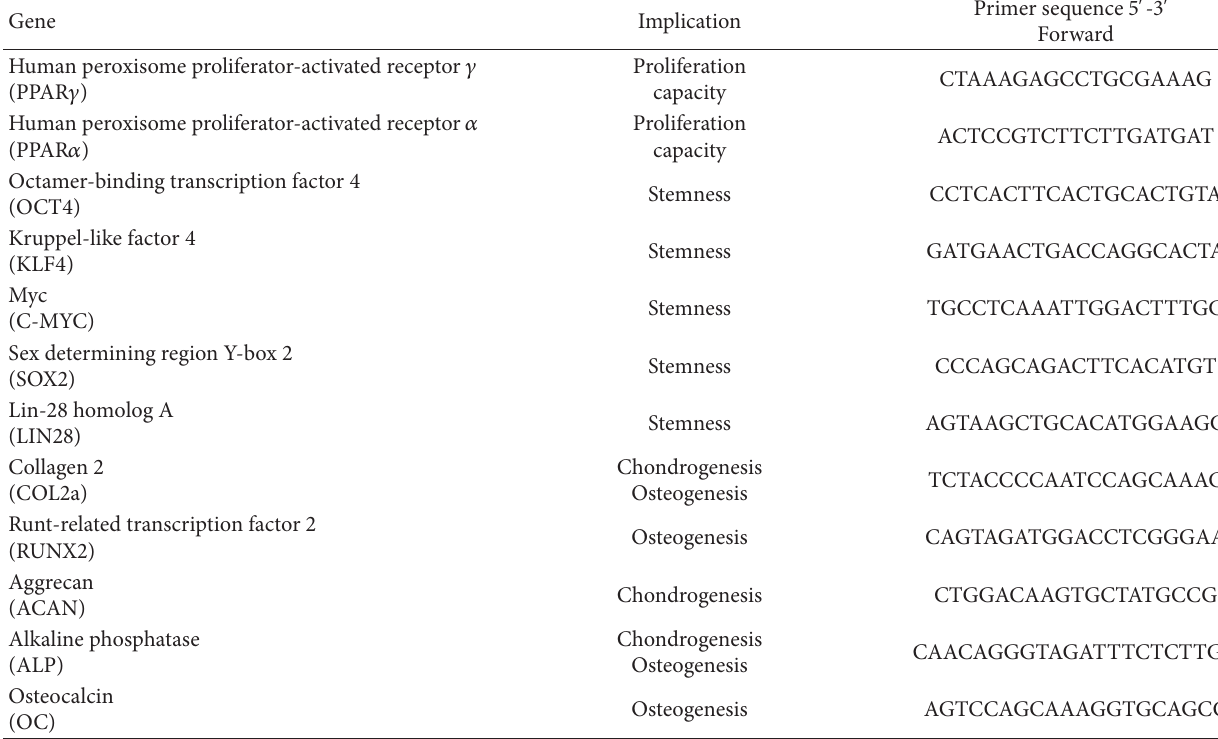
Table 2: Selected genes and primers involved in human iPSC-MSC technology